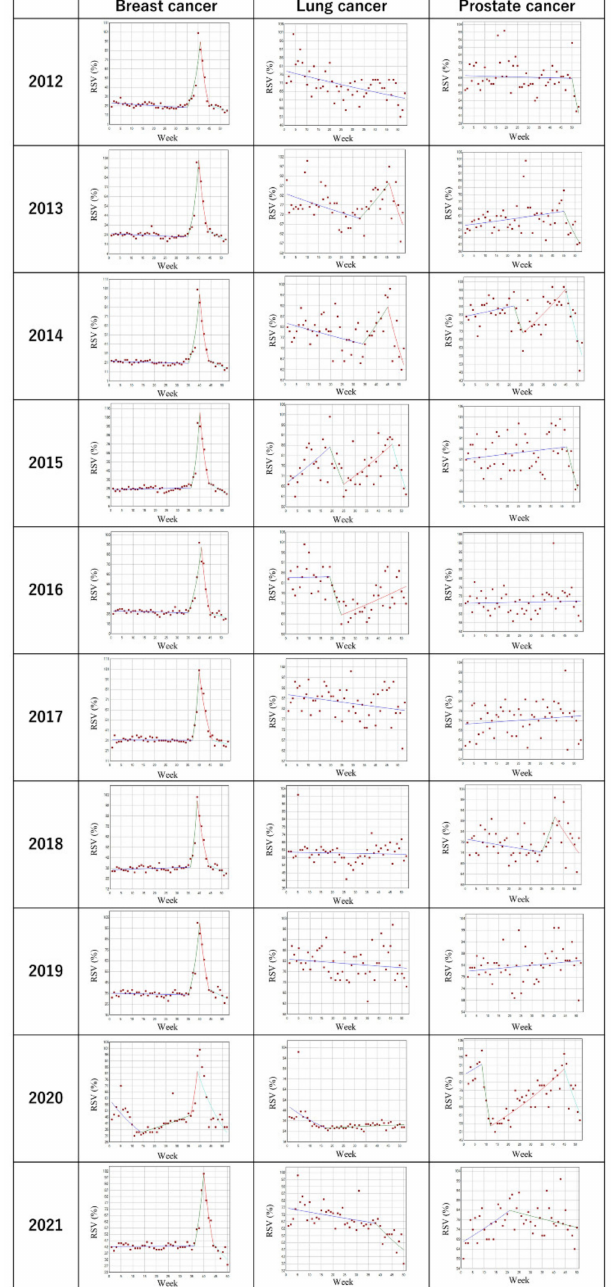
Figure 2. Trends in the weekly relative search volumes of “Breast cancer”, “Lung cancer”, and “Prostate cancer” in the United States (2012–2021). Weekly relative search volumes (RSVs) for the search terms “Breast cancer”, “Lung cancer”, and “Prostate cancer” are described. World Antimi- crobial Awareness Week (WAAW) occurred in the 47th week of 2015, 2016, 2018, 2019, and 2020 and the 46th week of 2017. In the search results of the worldwide analysis in 2017 and 2020, the third joinpoints were identified around the time of WAAW (during the 48th week and 47th week, respectively). The number of slopes is determined by the number of joinpoints identified by the analysis. Joinpoints are the time points when statistically significant changes in the linear slopes are